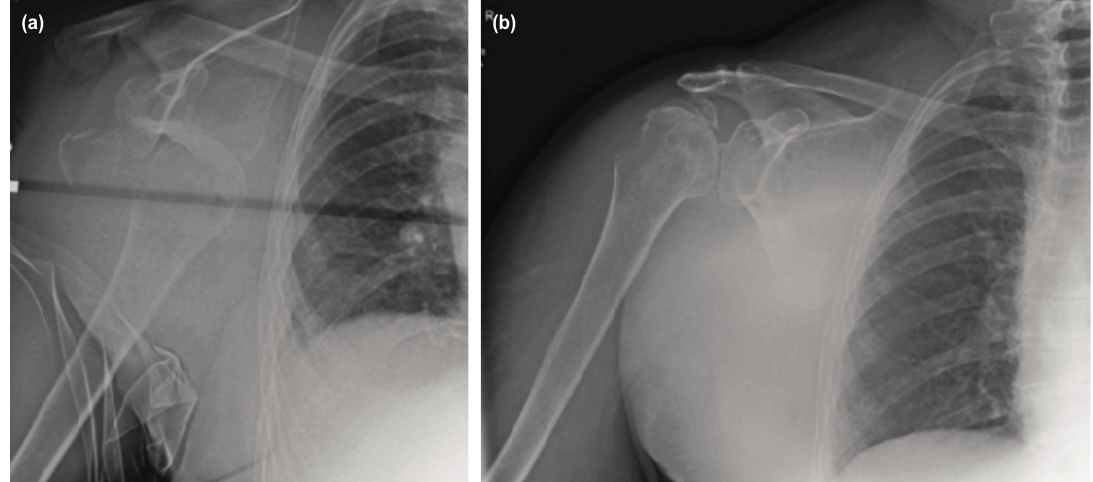
Radiographs of right shoulder (a) AP view showing anterior fracture dislocation, (b) Post-manipulation showing reduction of Fig. 1: dislocation and displaced greater tuberosity fracture fragments.